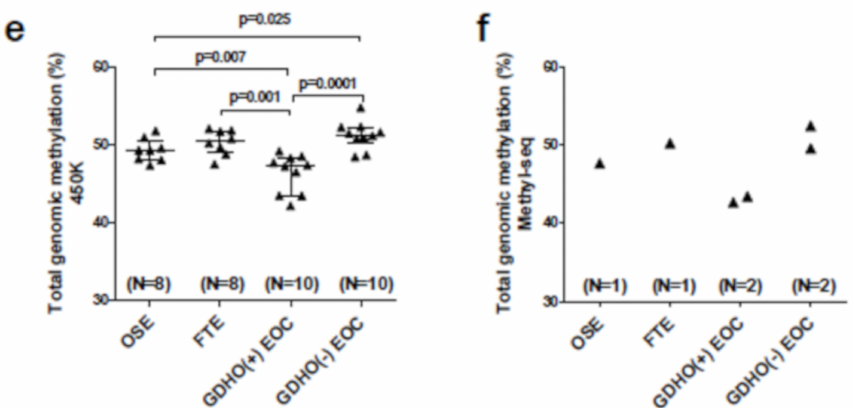
Figure 5. DNA methylome analysis of GDHO ( + ) EOC. ( a ) Dendogram showing relatedness of OSE, FTE, GDHO ( + ) EOC, and GDHO (–) EOC DNA methylomes, using Illumina 450K data. Data for the 1000 most variable CpG sites is shown. ( b ) Principal component analysis (PCA) of sample groups, using 450K data. ( c ) Dendogram showing relatedness of OSE, FTE, GDHO ( + ) EOC, and GDHO (–) EOC methylomes, using Methyl-seq data. The 1000 most variable CpG sites is shown. ( d ) PCA of sample groups using Methyl-seq data. ( e ) Total genomic methylation of OSE, FTE and EOC sample groups as determined using 450K data. Median and interquartile ranges are plotted, and the unpaired two-tailed t-test p-values are shown. ( f ) Total genomic methylation of OSE, FTE and EOC sample groups as determined using Methyl-seq